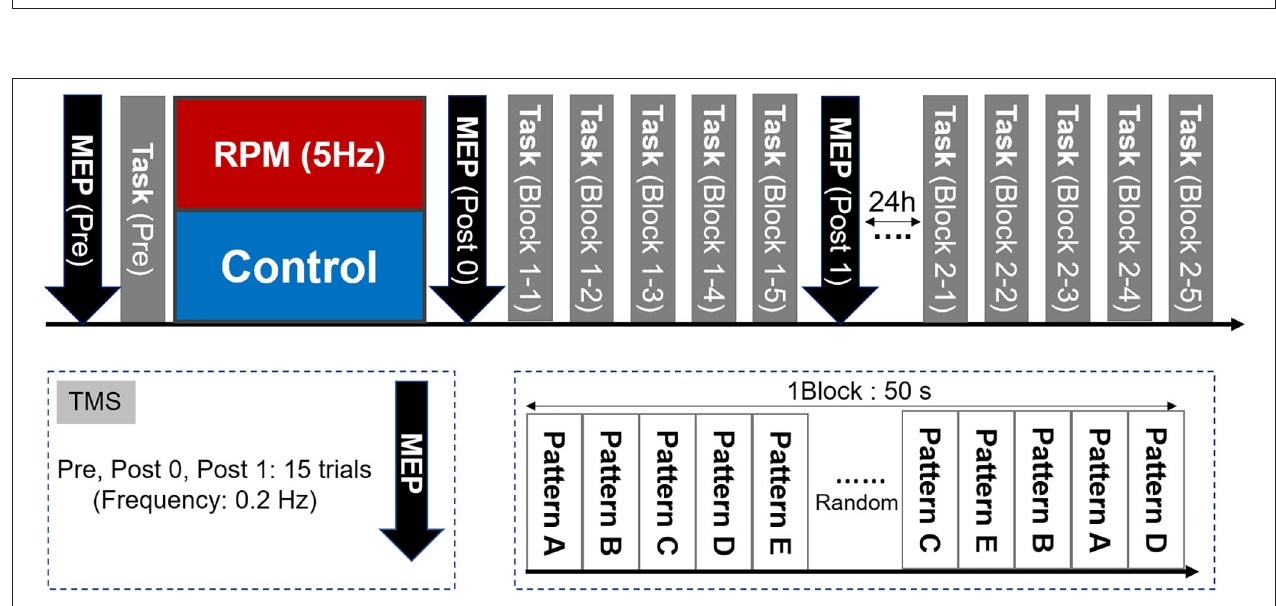
FIGURE 2 | (A) Visual Tracking Task. The tension gauge was fixed to the right index finger, and the abduction tension was measured. (B) Target waveform. The blue circle indicates the manipulation markers that moved up and down according to the subject’s abduction tension. The blue line shows the target waveform. The target waveform was set to 0–15% of the subject’s maximum abduction force and was presented as moving from right to left on the monitor. The subject adjusted the abduction force of the indicated finger so that the manipulated marker accurately overlapped with the target waveform on the monitor.